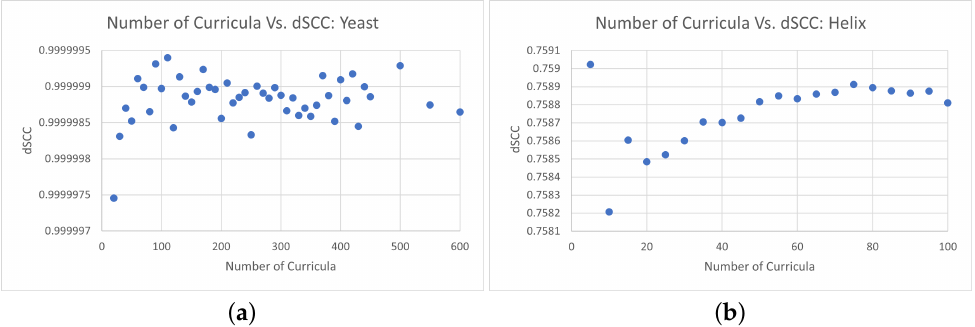
Figure 4. ( a ) Variation in average dSCC for various numbers of curricula evaluated on the yeast data over 30 trials. ( b ) Variation in average dSCC for various numbers of curricula evaluated on the helical data over 30 trials.